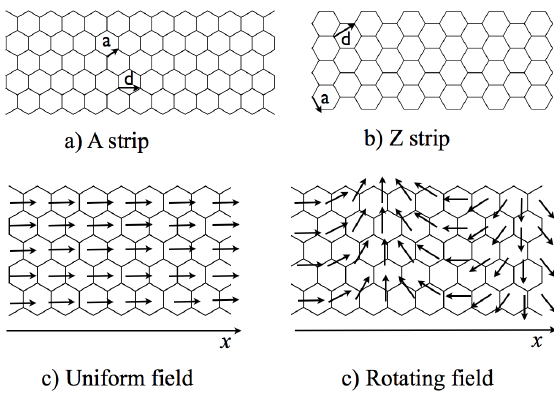
Figure 1: a) Graphene strip with short armchair edges (A strip) b) Graphene strip with short zigzag edges (Z strip) c) Magnetic field configuration for an in-plane uniform field d) Magnetic field configuration for a rotating in-plane